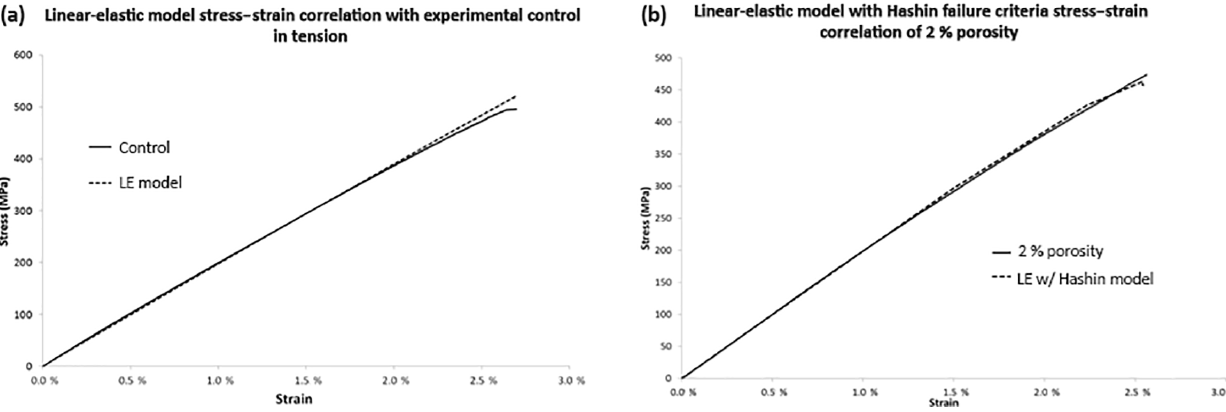
quite consistent through the initial low-load portion of each analysis in which shear load increased significantly through the wavy section for all the modeling